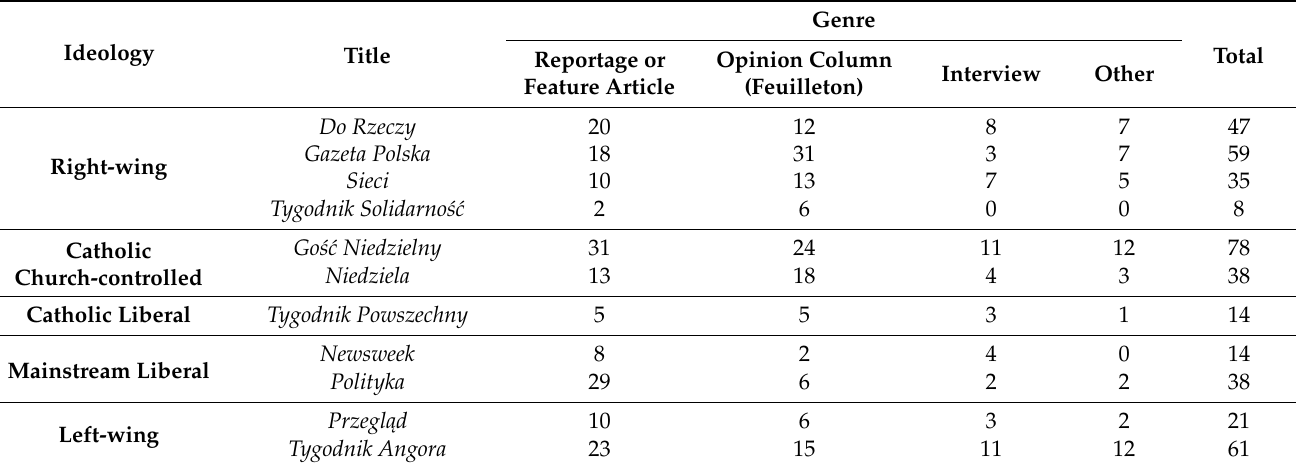
Table 2. The typology of texts relating to the crisis in the Catholic Church published in Polish opinion-forming weeklies at the end of